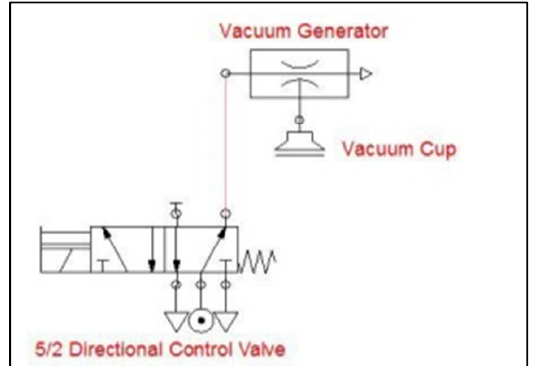
Fig. 5. Electro-pneumatic circuit of the